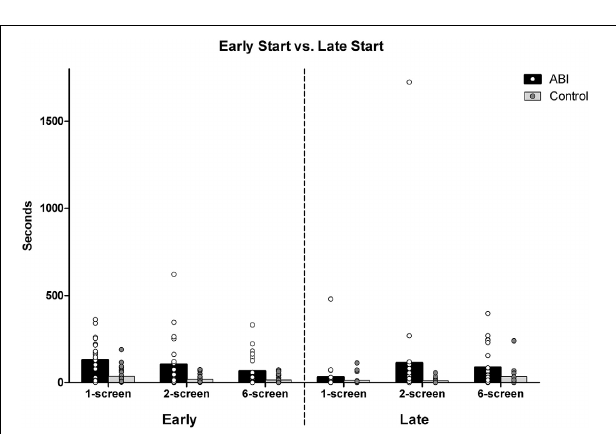
FIGURE 6 | Average deviation of start times in seconds.